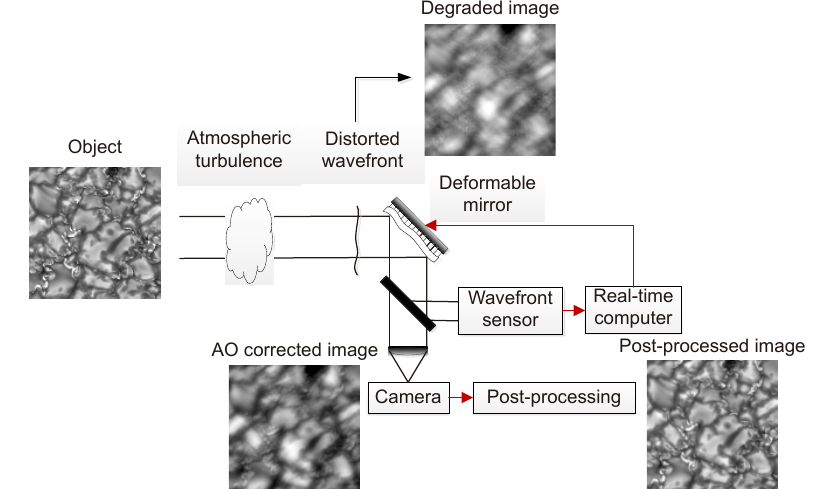
Fig. 1 | Overview of AOS for solar observation. The light waves emitted by the Sun suffer from wavefront distortion when pass through the atmospheric turbulence. The WFS detects the intensity distributions caused by the wavefront distortion and then transfers them to the RTC. The RTC reconstructs the wavefront and calculates the voltages sent to the DM to compensate the distorted wavefront. Meanwhile, the scientific camera records the corrected images and sends them for post-processing in order to get even higher resolution.